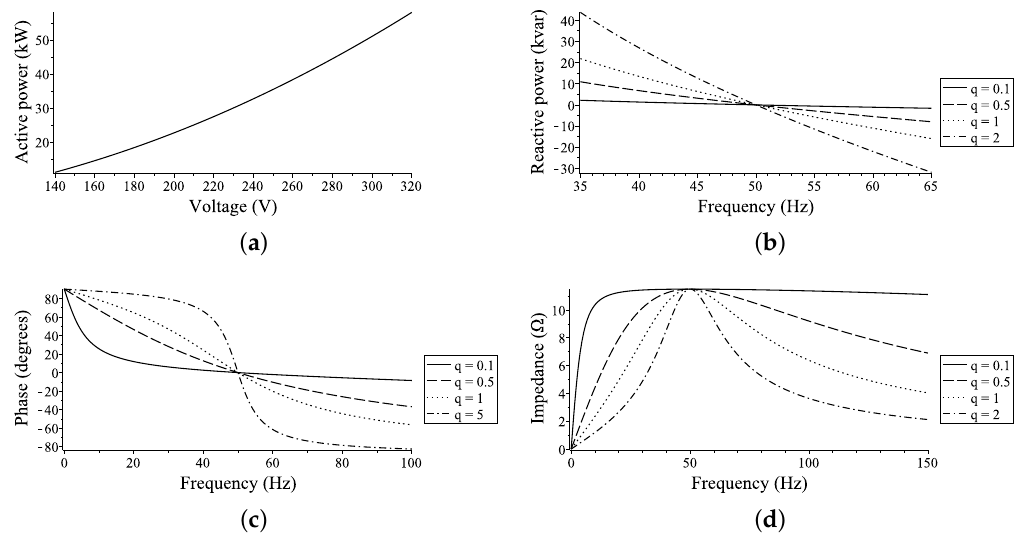
Figure 5. Resonant load characteristics. ( a ) Active power versus voltage of a 50-Hz resonant load. ( b ) Reactive power versus frequency of a 50-Hz resonant load. ( c ) Phase versus frequency of a 50-Hz resonant load. ( d ) Impedance versus frequency of a 50-Hz resonant